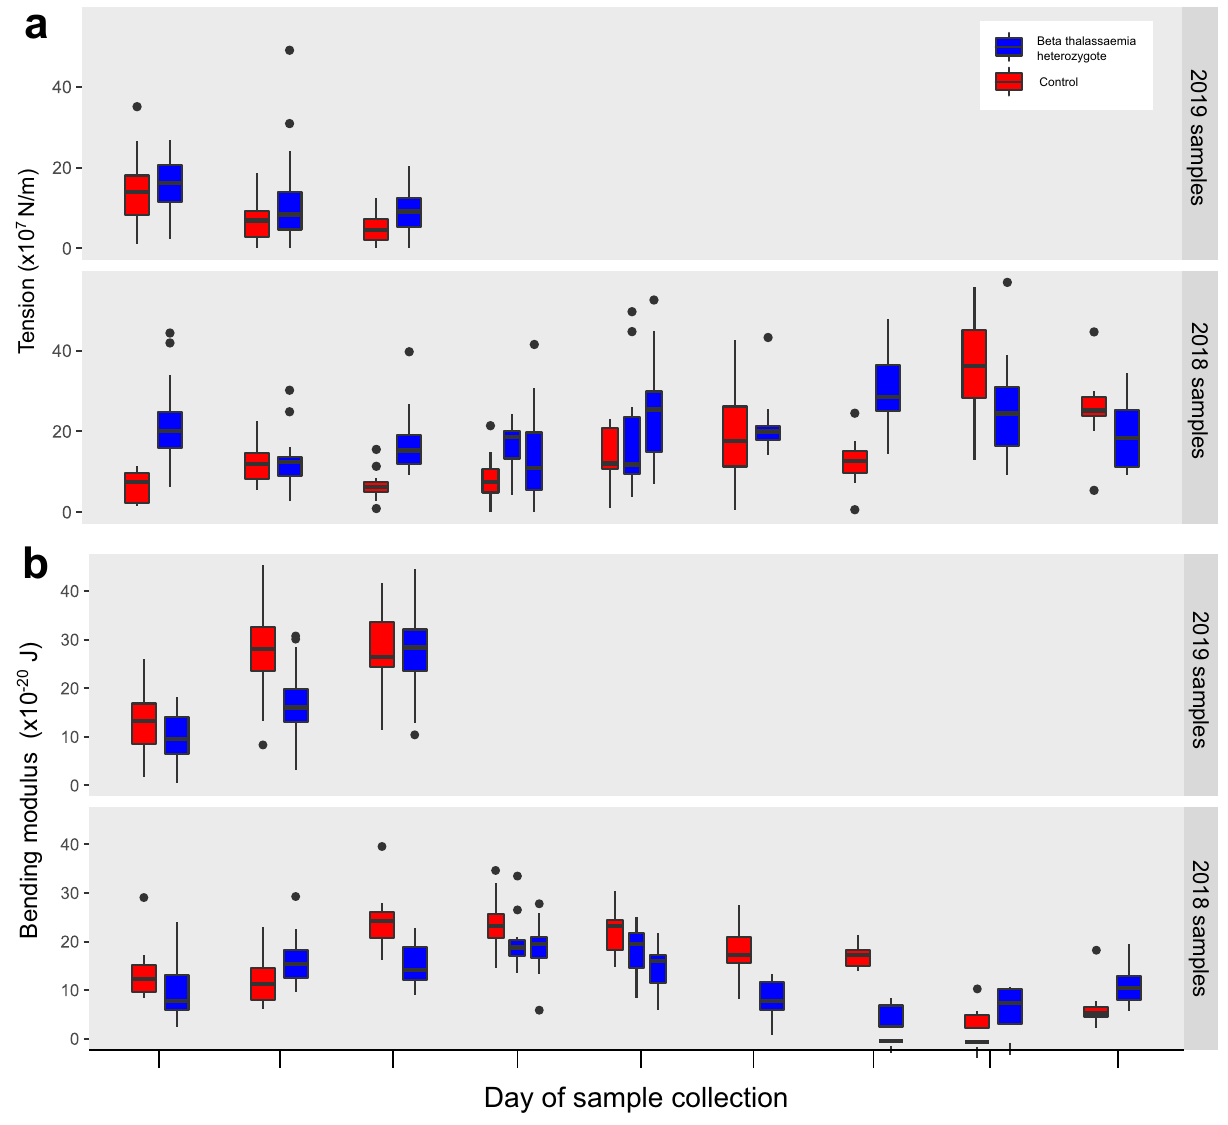
Figure 1. Membrane tension and bending modulus in beta thalassaemic erythrocytes. The boxplots in panels ( a ) and ( b ) display the erythrocyte membrane tension ( a ) or bending modulus ( b ) measured for 14 beta thalassaemia heterozygotes (blue boxplots) and 12 control non-beta thalassaemic samples (red boxplots). Samples subject to the same conditions (i.e. gathered on the same day and tested as part of the same batch) are grouped together. In two cases, two beta thalassaemic samples were gathered on the same day and a single control non-beta thalassaemic sample from that day was used for both. The number of cells measured to produce the results in each boxplot range between 7 and 50, and 2019 samples spent less time in transit than 2018 samples and hence were fresher (see